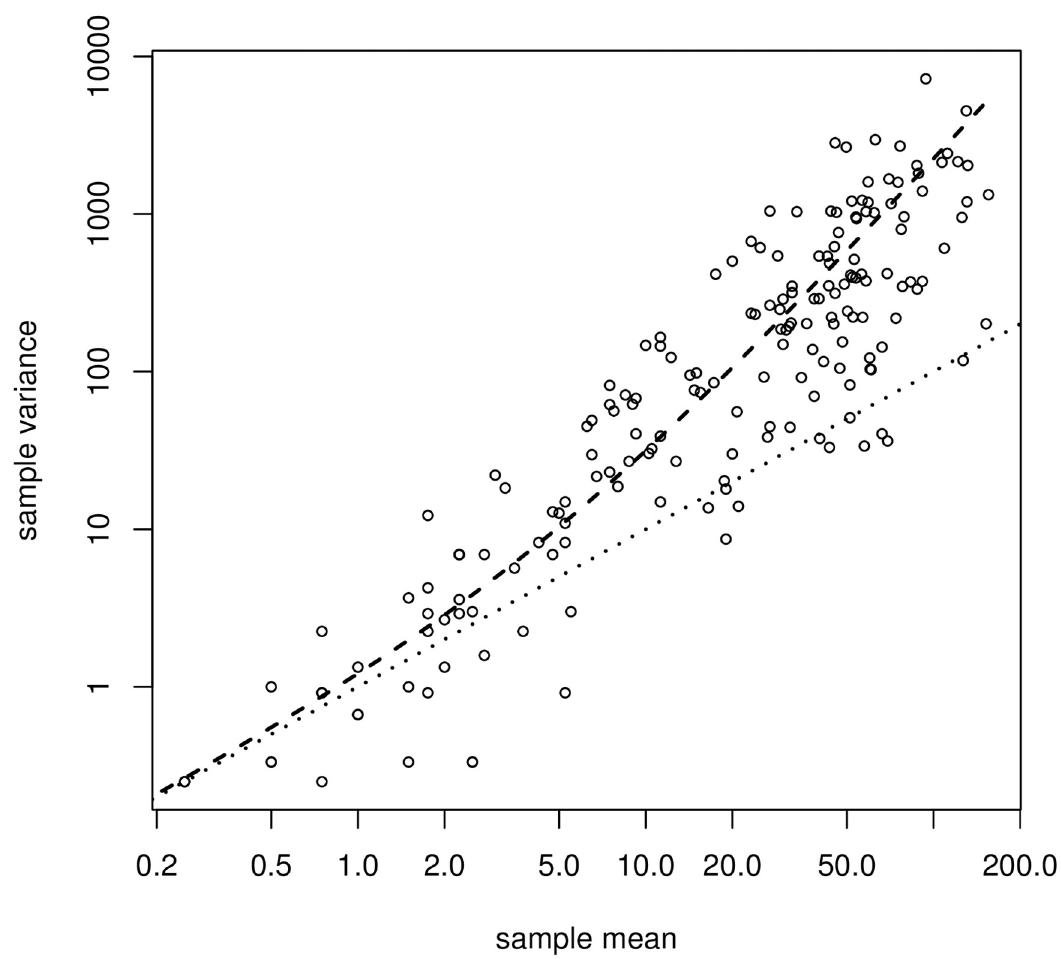
Fig 2. Sample variance as a function of sample means across measurements. Dashed line is fit using a NB(4.66)-model; dotted line is fit using a Poisson model Each sample consisted of four